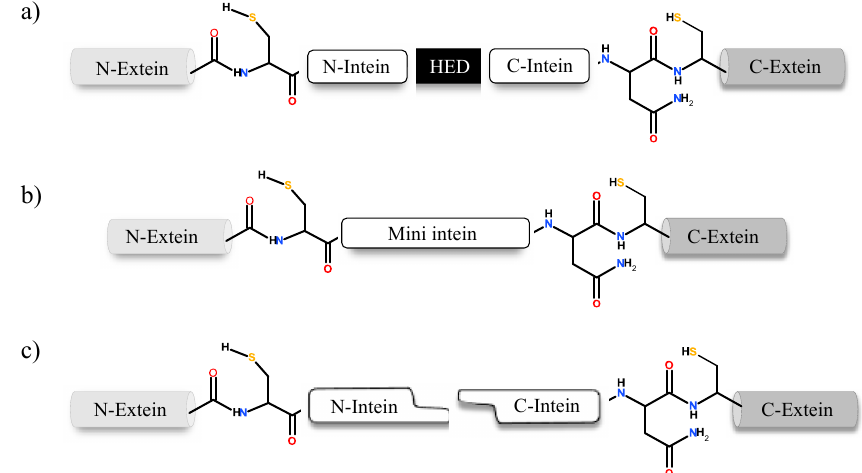
Figure 1. Intein configurations. Schematic representation of various types of intein: ( a ) full length intein with Homing endonuclease domain (HED), ( b ) mini-intein and ( c ) split intein.